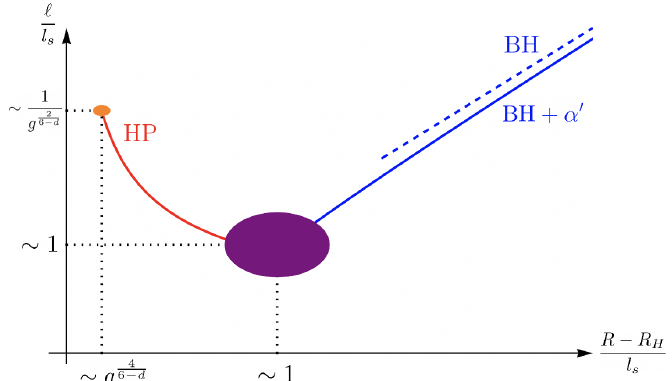
Figure 1 . In red, the size of the Horowitz-Polchinski (HP) solution as a function of the temperature, 4 or R − R , for d = 3 , 4 , 5 . The HP description breaks down at R − R , as denoted by 6 − d l s H H ∼ g the orange blob, where we should transit to the free string picture. In dashed blue, we also plot the curve for a black hole (BH), applicable when R (cid:29) l . We also sketched the known leading α 0 s correction for the black hole [1–3] in solid blue, which lowers the temperature for a fixed size (the leading correction vanishes for d = 3 in the bosonic or heterotic case). The intermediate regime between the HP and BH descriptions, being the focus of section 3, is represented by the purple blob and is not analytically tractable at present. The plot, as well as figure 3, 5, 7, are only